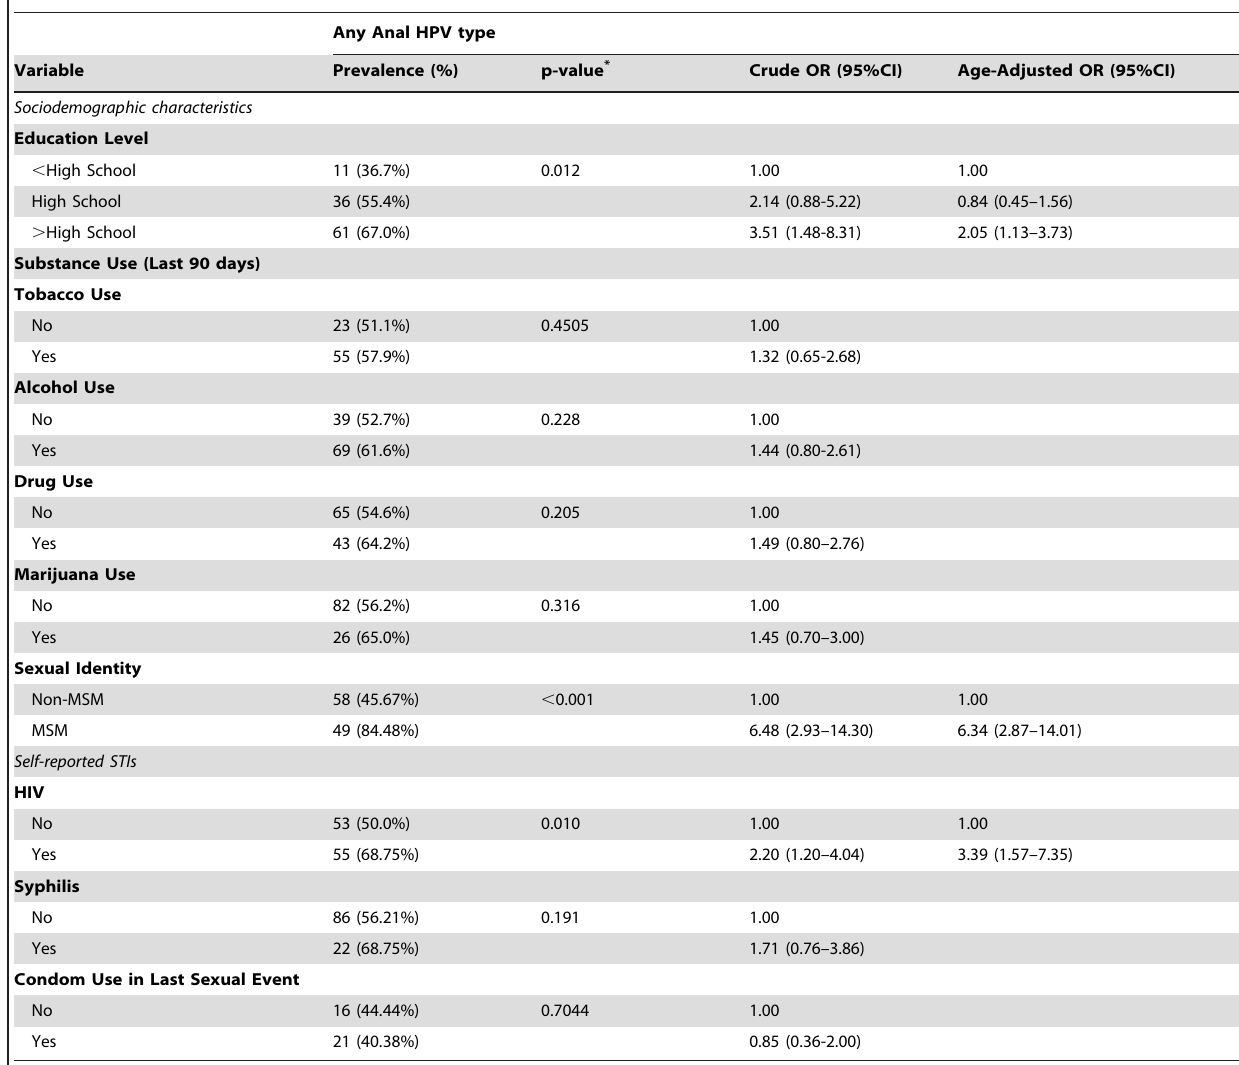
Table 3. Prevalence and Correlates Associated with Anal HPV Infection (Any